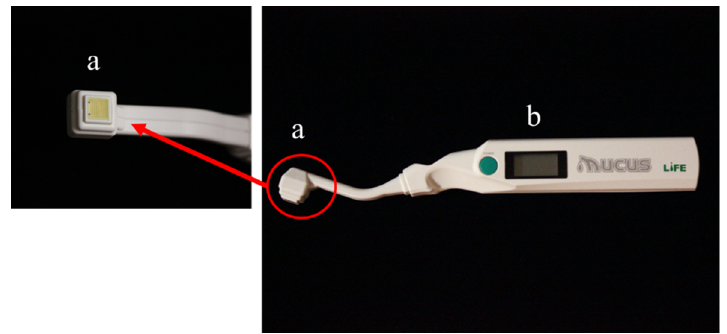
Figure 1. Mucus ® ; Life Co., Ltd., Saitama, Japan, ( a ) is a capacitance sensor; ( b ) is the score display.